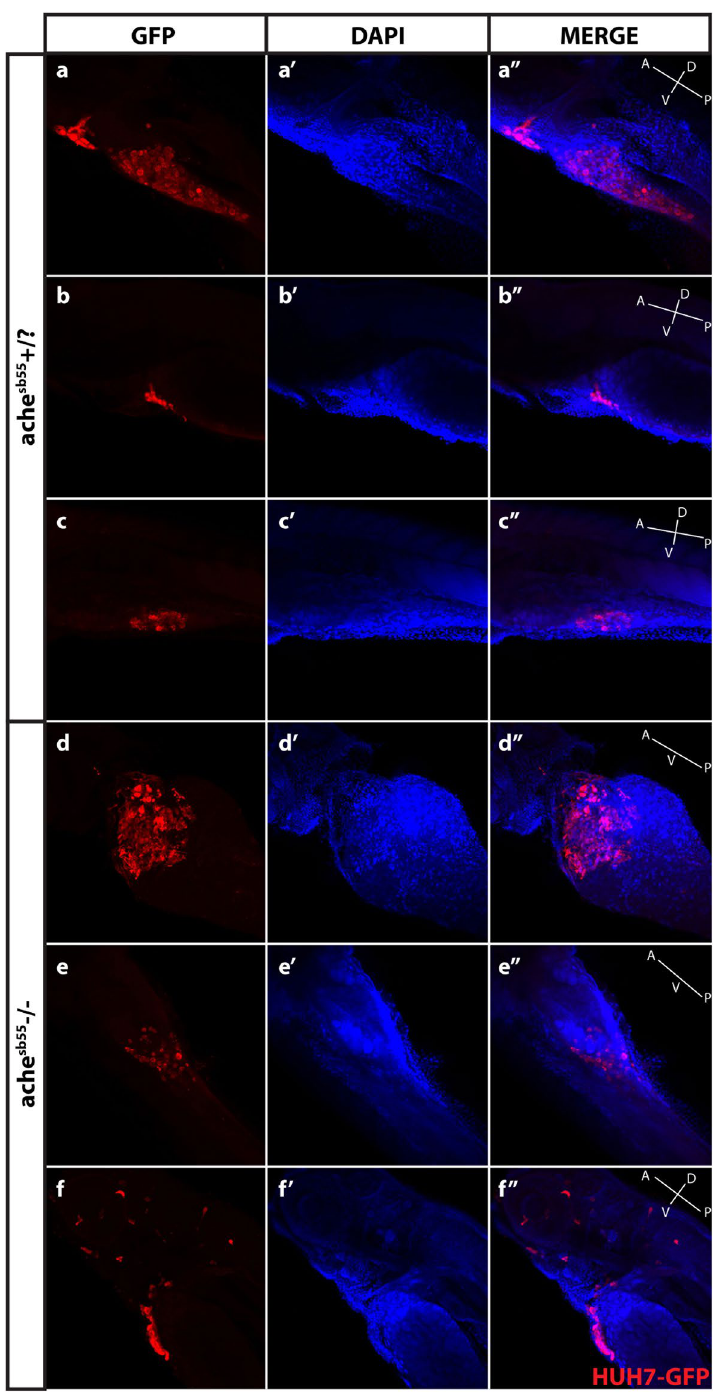
Figure 6. Optical sectioning and examination of Huh7-GFP xenografted larvae. Larvae ( ache + /? and ache − / − ) injected with Huh7-GFP cells were stained with GFP primary antibody and Cy3 tagged secondary antibody, and counterstained with DAPI and examined histologically by optical sectioning using a Zeiss LSM 880 confocal microscope. ( a – f ) At 20 × magnification, z-stacks at 10 micron intervals were obtained and consecutive images were Z-projected to obtain these 2D images by maximum intensity projection in ImageJ. Tumor masses can be clearly seen in both images in red. (a’–f’) Same larvae were counterstained with DAPI for marking nuclei. (a”–f”) Merged images were presented. In the fish body schematic, the letters are abbreviations for A : anterior, P : posterior, D : dorsal, V :